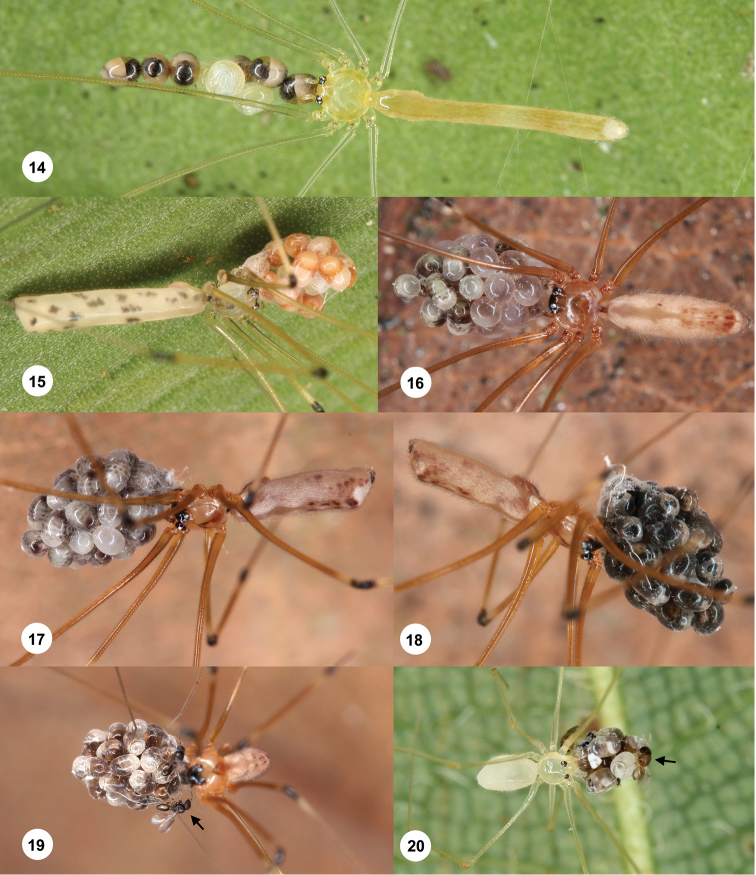
Host spiders with parasitized egg-sacs. 14Nipisaphyllicola (Mal276); note that two eggs are not parasitized 15Panjangecamiguin (Phi291) 16Tissahamiabukittimah (Mal256); note that only some of the eggs are parasitized 17–19Tissahamiagombak (Mal305) at different stages of wasp development (6 days lie between 17 and 18 1 day between 18 and 19); arrow points at eclosed wasp 20Belisanakhaosok (Mal331); arrow points at eclosed wasp.